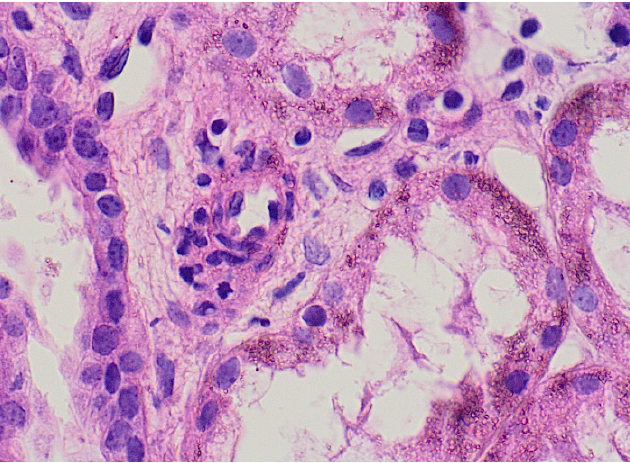
Figure 3. Skin biopsy from 3-year-old boy with picture of leukocytoclastic vasculitis.